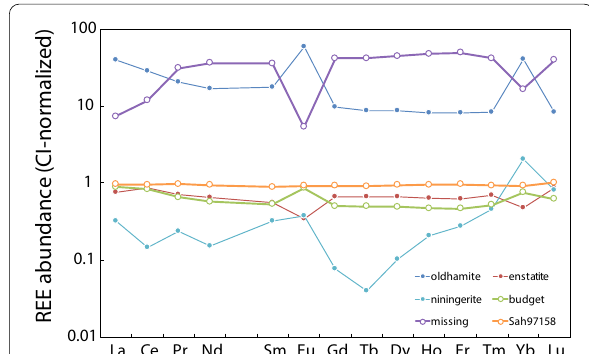
Fig. 7 Summary of CI-normalized REE patterns of EH3 as determined by whole-rock analysis, together with its constituent minerals and the reconstructed pattern by mixing the minerals in modal proportions. The mismatch between the whole-rock and the reconstructed compositions, the missing component, is also illustrated. CI values are from Barrat et al. (2012)